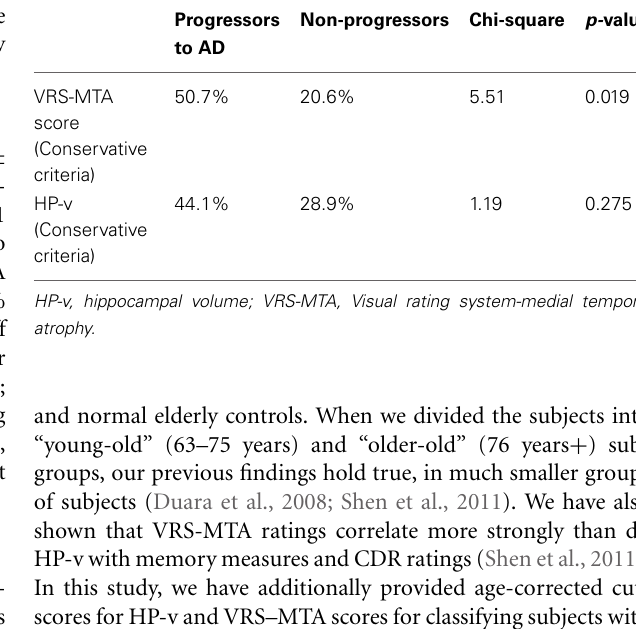
Table 4 | VRS-MTA score, HP-v and progression from aMCI to